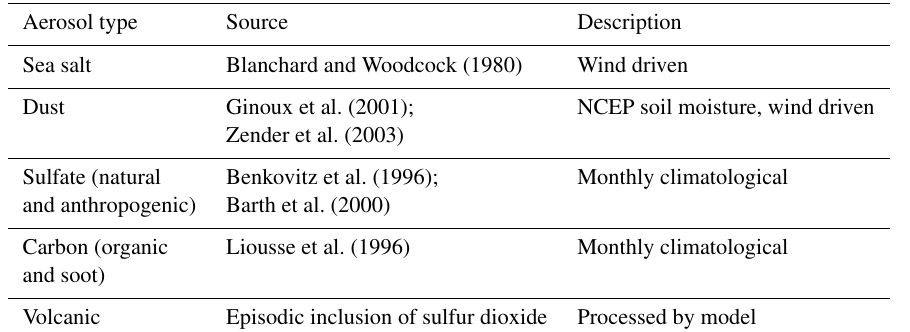
Table 1. Aerosol types and climatological sources.